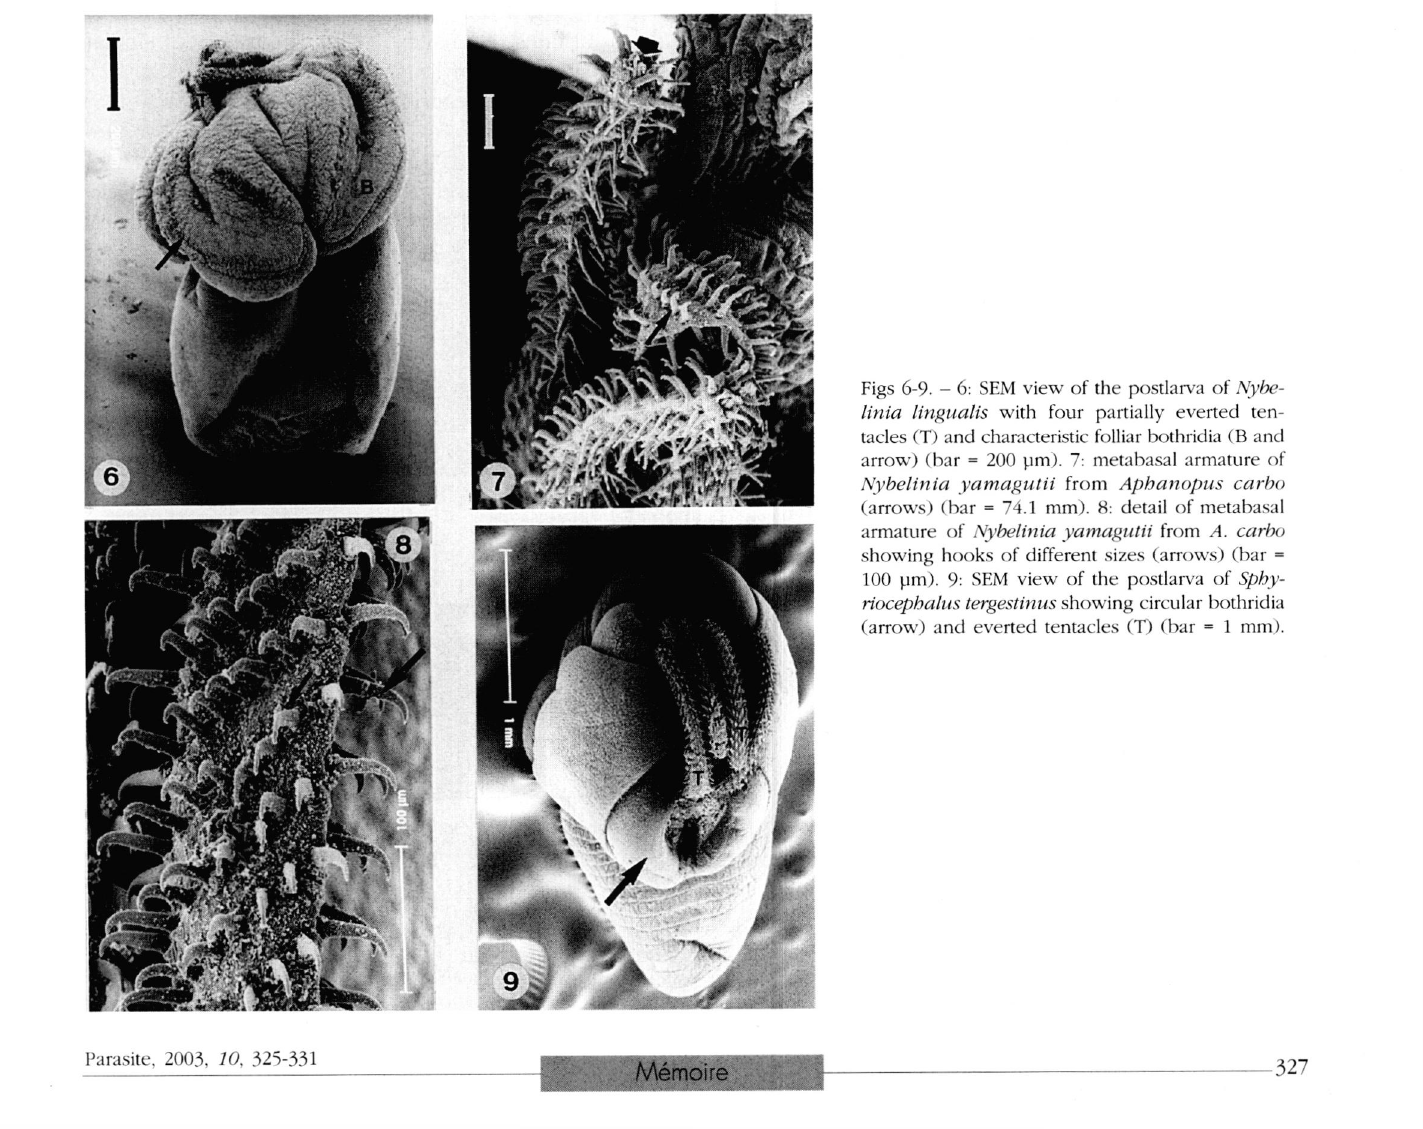
Figs 6-9. - 6: SEM view of the postlarva of Nybe linia lingualis with four partially everted ten tacles (T) and characteristic folliar bothridia (B and arrow) (bar = 200 µ m). 7: meabasal armature of Nybelinia yamagutii from Aphanopus carbo (arrows) (bar = 74.1 mm). 8: detail of metabasal armature of Nybelinia yamagutii from A. carbo showing hooks of different sizes (arrows) (bar = 100 pm). 9: SEM view of the postlarva of Sphy riocephalus tergestinus showing circular bothridia (arrow) and everted tentacles (T) (bar = 1